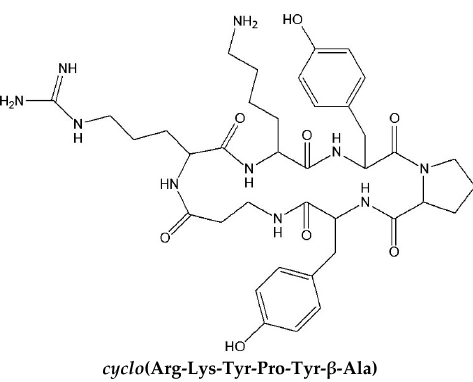
Figure 7. The optimized cyclohexapeptide library component, deconvoluted by Chiari et al. [45].